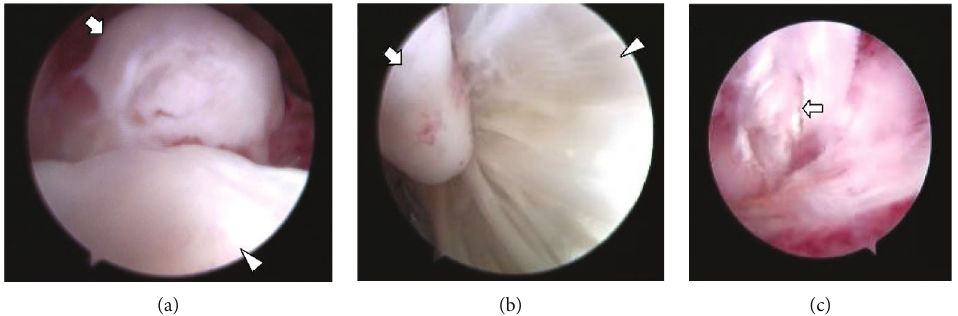
Figure 5: Arthroscopic views of the posterior aspect of the right ankle. (a) A large loose body from the right posterior ankle extra-articular space (arrow) can be visualized. The arrowhead follows the superior-posterior aspect of the calcaneus. (b) Friction between a loose body (arrow) and the FHL tendon (arrowhead) can be seen. (c) A longitudinal tear and fi brillation were detected in the FHL tendon (arrow). FHL: fl exor hallucis